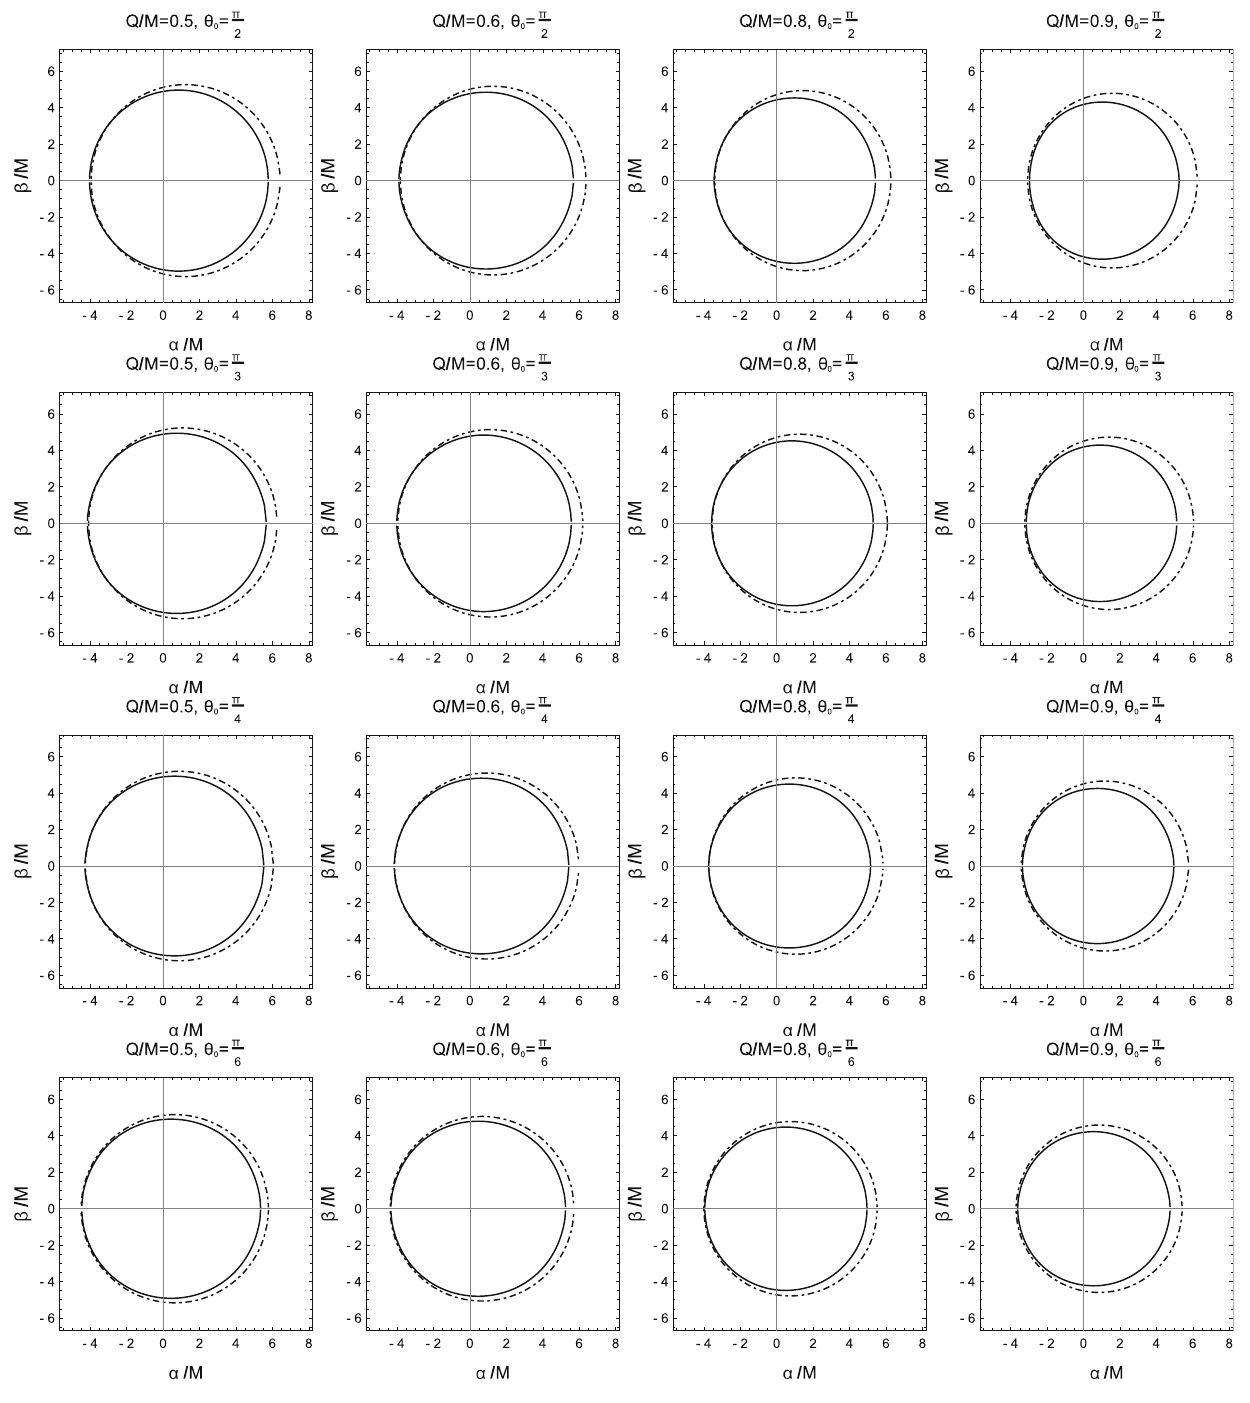
Fig. 4 The shadow of the black hole surrounded by a plasma for the different values of the charge parameter Q , inclination angle θ 0 , and the refraction index n . The solid lines in the plots correspond to the vacuum case, while for dotdashed lines the plasma frequency is k / M = 0.5 and a =